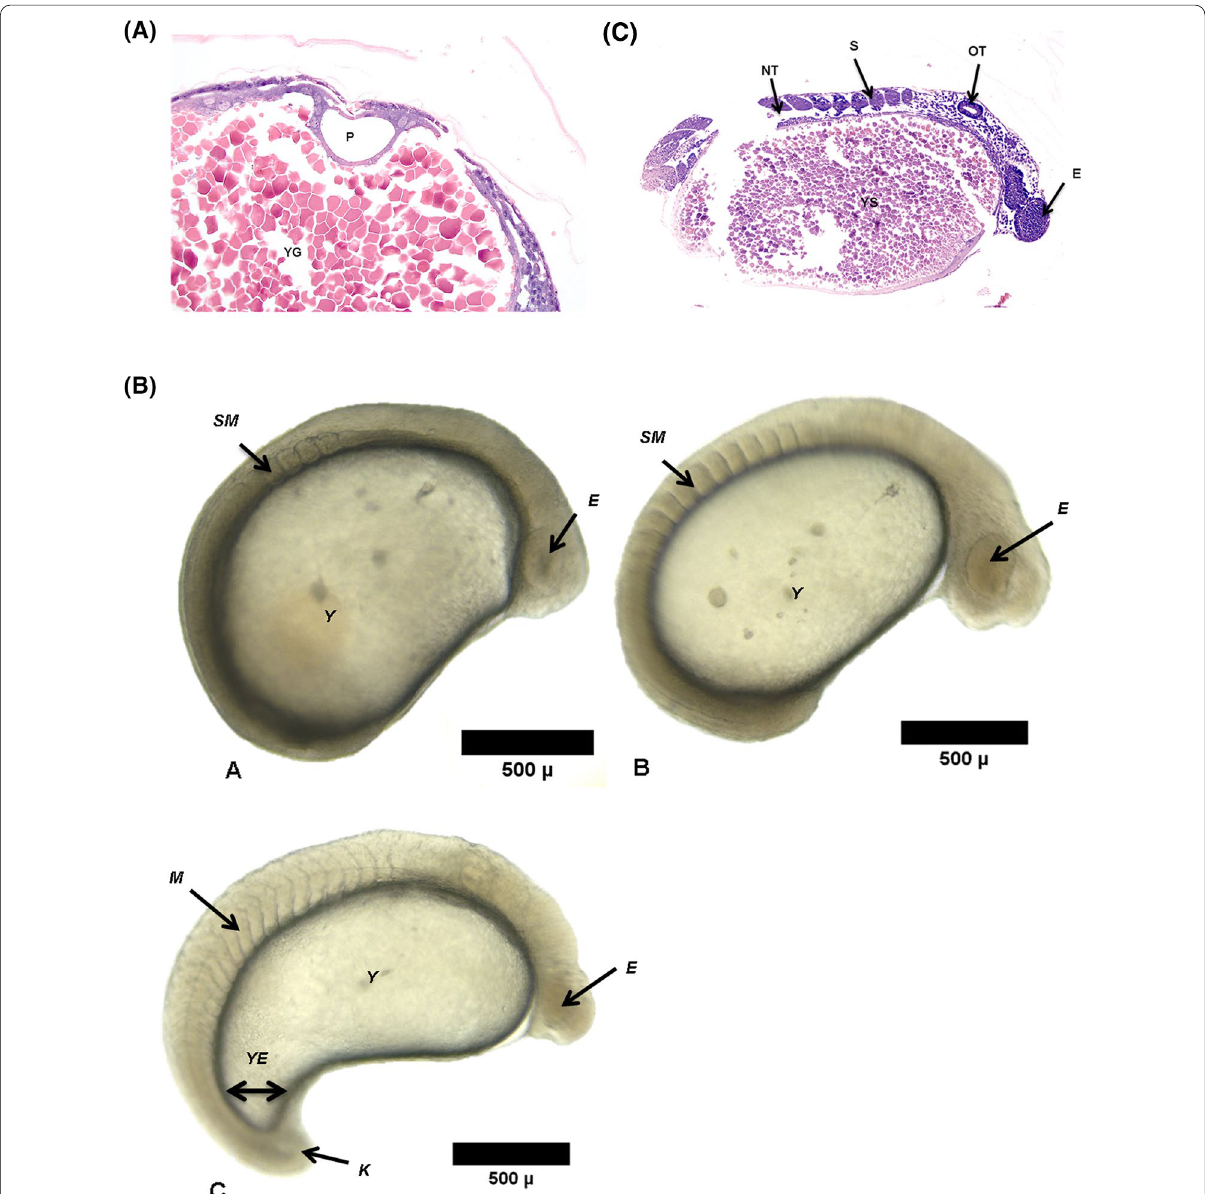
Fig. 6 A Prochilodus magdalenae , developmental segmentation and organogenesis period, the anlage organ or primordium of the CNS is recognized, H&E 20X. Abbreviations: P: primordium of the CNS; YG: yolk granules. B Prochilodus magdalenae segmentation period. (A) Life embryos with: 4–6 somites; (B) 18 somites; (C) 25 somites. The optic placodes become discernible as solid masses, the head subdivision is more apparent, and the tail bud is more prominent. Abbreviations: E: eye; K: Kupffer’s vesicle; M: myomere; S: shield; SM: somites; Y: yolk; YE: yolk extension. C Prochilodus magdalenae segmentation period. The neural tube is recognized. Further, the somites, tail, and eye can be observed, H&E 4x. Abbreviations: NT: neural tube; E: eye; S: somite; YS: yolk